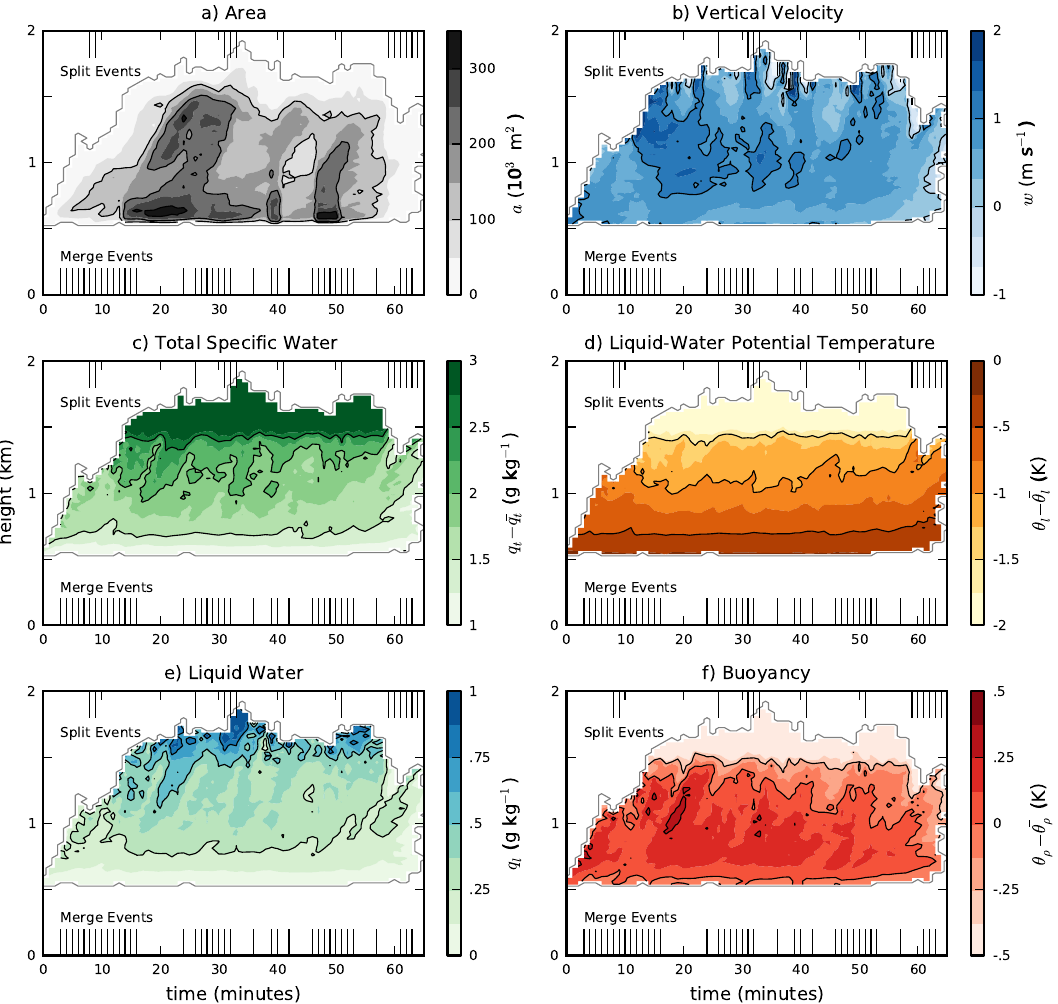
Fig. 4. Height-time profiles of (a) horizontal cross-sectional area, (b) vertical velocity, (c) total specific water surplus, (d) liquid-water potential temperature deficit, (e) specific liquid water and (f) buoyancy of the condensed liquid water region of the longest-lived tracked cloud. Surplus and deficit values in (c) and (d) are relative to the horizontal mean properties of the model. The black lines in (b) and (f) denote the zero contours. The longer line markers at the top and bottom of the plots denote the times at which clouds split from and merge into this cloud,